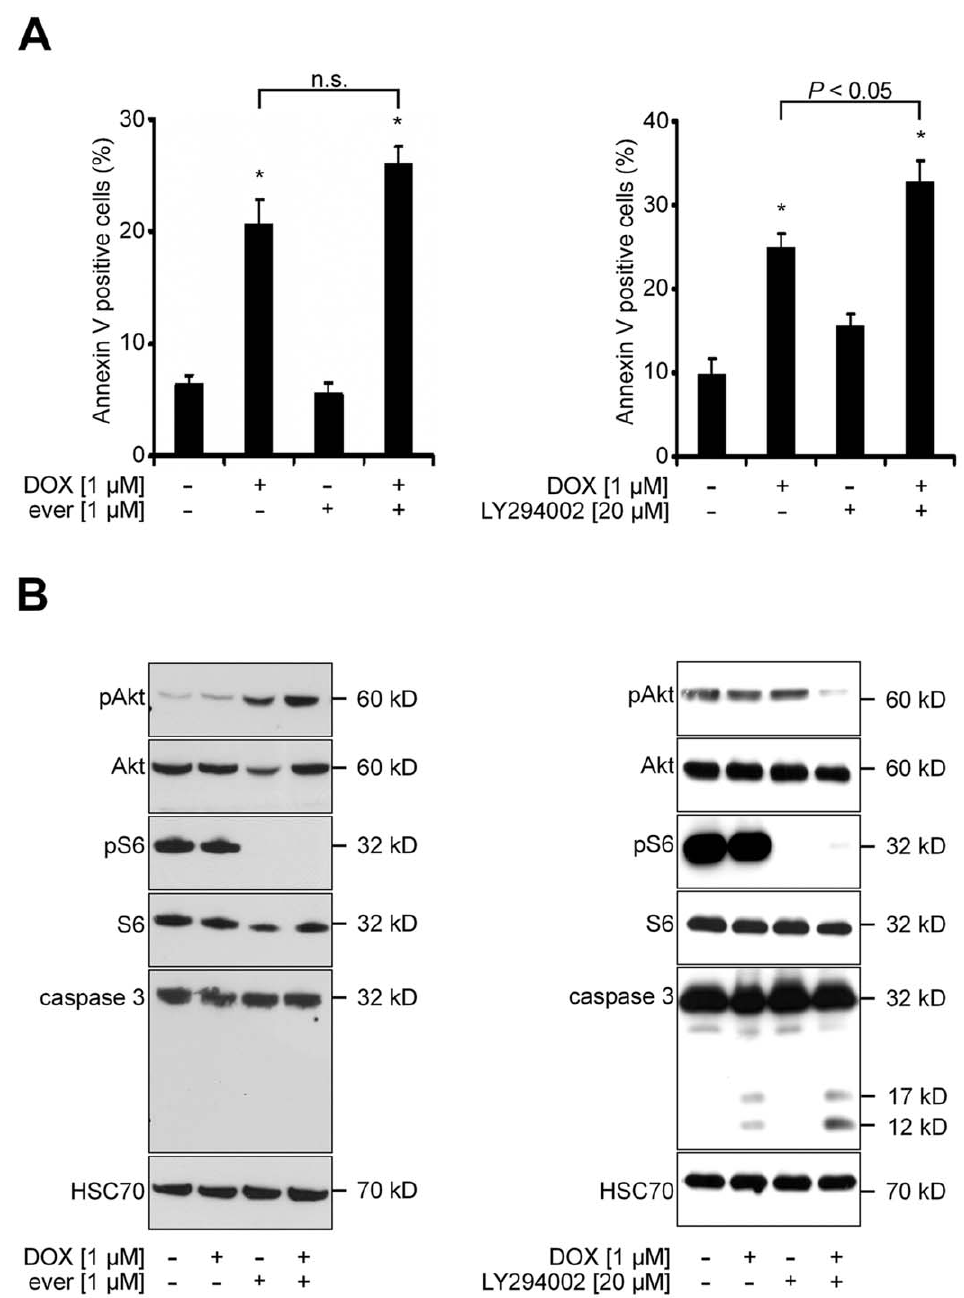
Figure 4. Inhibition of mTOR does not sensitize RD cells to DOX-induced apoptosis. A) and B) RD cells were treated for 24h with 1 m M DOX and/or 1 m M everolimus (ever; respective left panels) or with 1 m M DOX and/or 20 m M LY294002 (respective right panels) or solvent. A) Annexin V positive RD cells were analysed by FACS. Data represent mean + SEM of two independent experiments performed in duplicates. n.s. not significant by Students t -test. B) Western blot